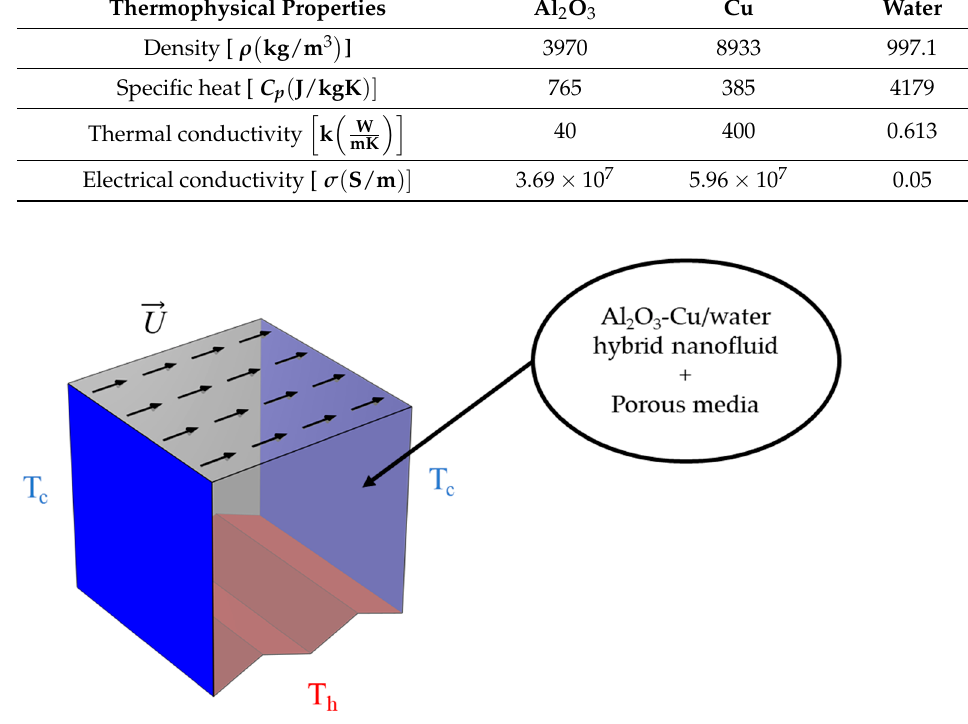
Figure 1. The physical domain and boundary conditions. Table 1. Thermophysical properties of solid nanoparticles ( (cid:4666)Al (cid:2870) O (cid:2871) and Cu(cid:4667) and base liquid (water) [33,34].